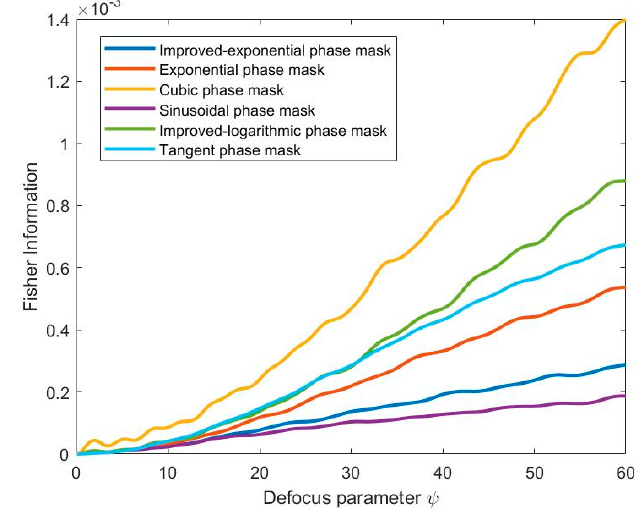
Figure 7. Fisher information of the six phase masks.